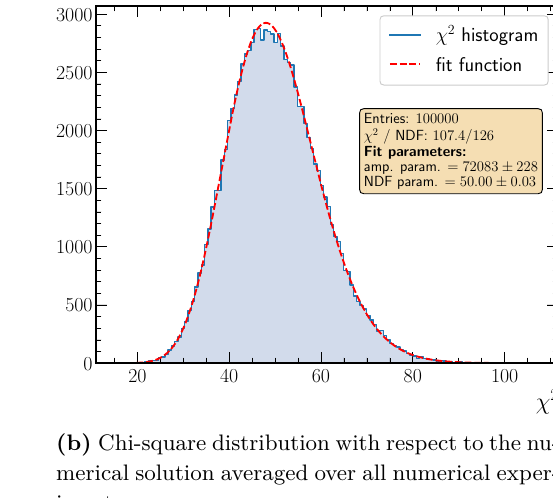
Figure 6. Chi-square distribution for the e + e − → ηπ + π − Born cross section obtained using the naive